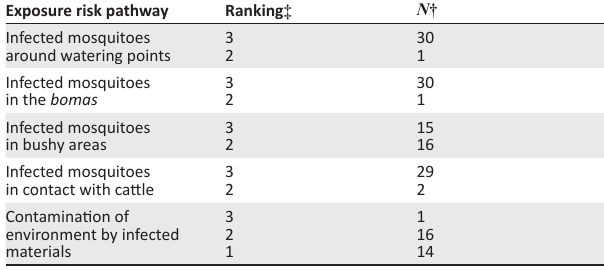
TABLE 3: Summarised results for qualitative ranking of Rift Valley fever exposure risk pathway in cattle as perceived by the pastoralists’ key informants in Ijara,